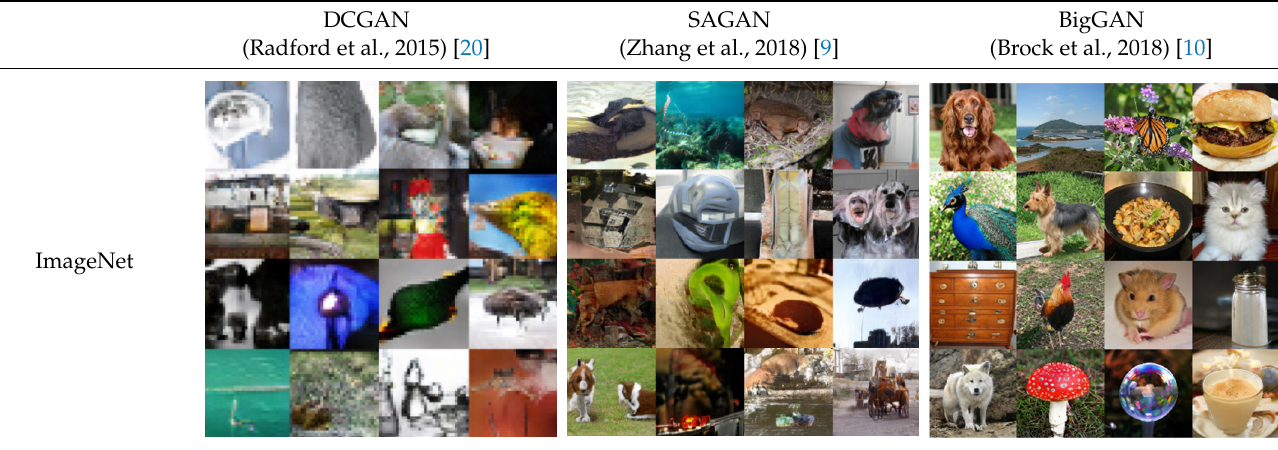
Table 3. Visual results of different models trained with the ImageNet dataset. More results are presented in that